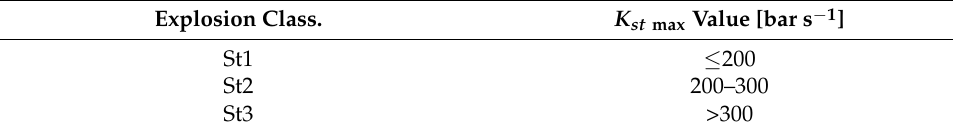
Table 1. Dust explosion classes [94]. Explosion Class.